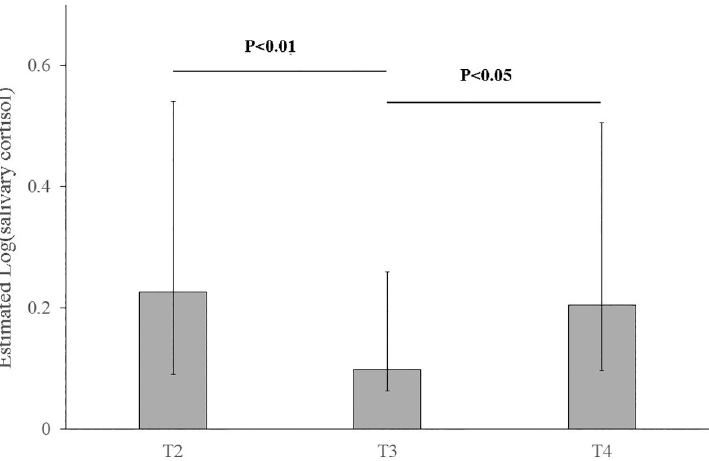
Fig 2. Logarithmic transformed salivary cortisol estimated by the model (grey columns) in the German shepherd pups. Horizontal black bars: significance of pairwise comparisons between different times of sampling (T2 vs T3 and T3 vs T4); vertical black bars: 95% confidence intervals; T2: the parturition day; T3: twenty-one days after parturition; T4: two months after